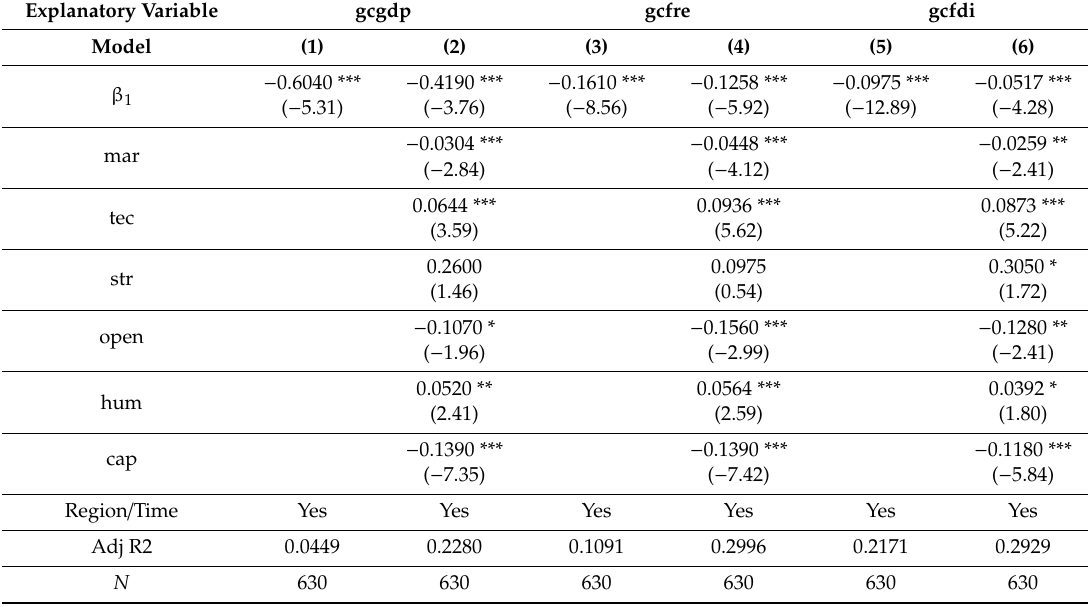
Table 5. Benchmark regression